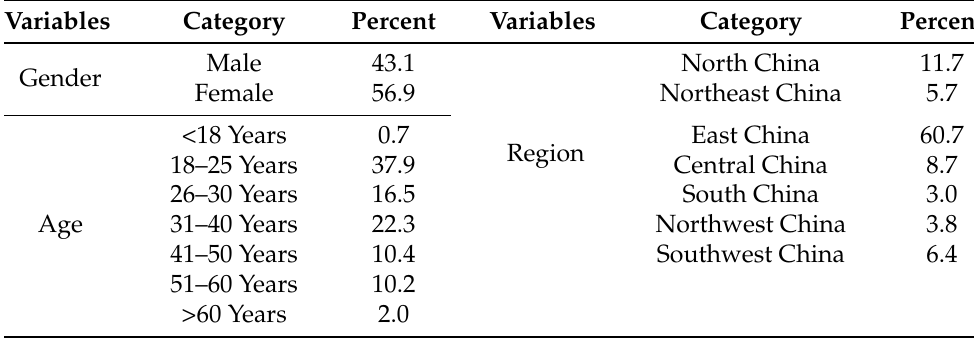
Table 1. Demographic characteristics of the